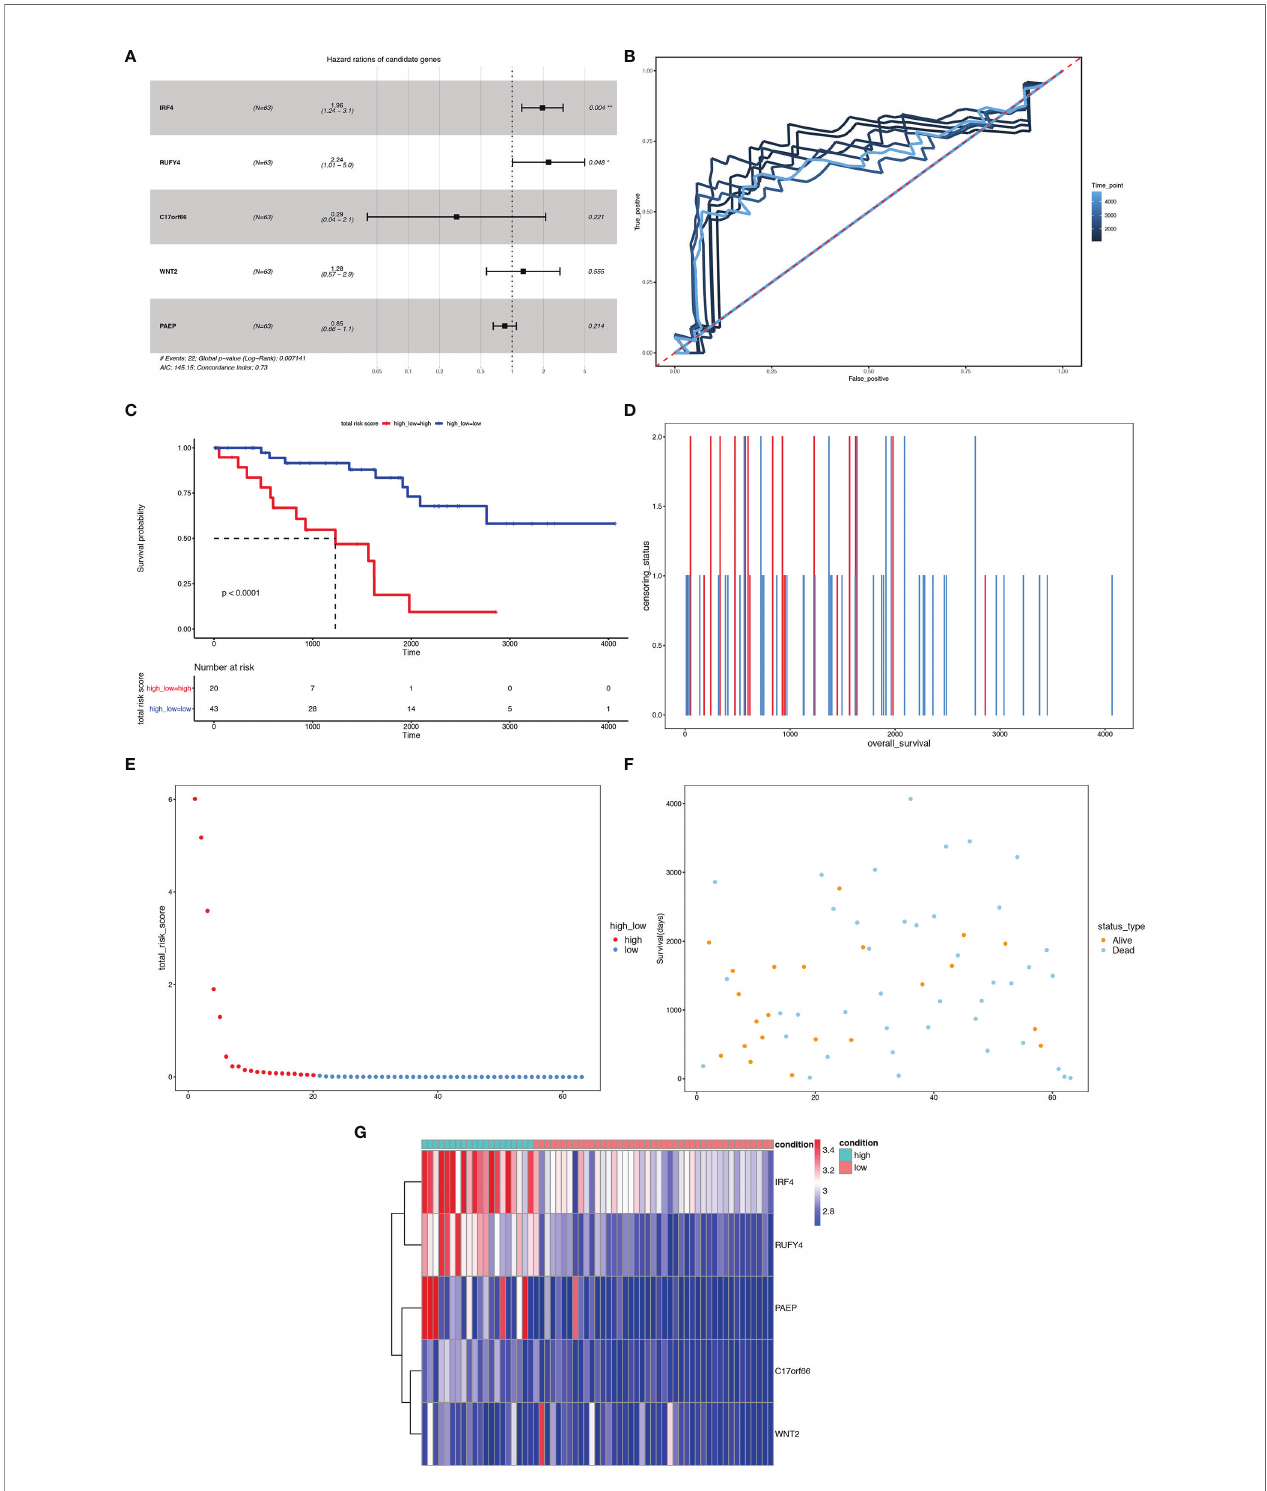
FIGURE 15 | Risk score analysis of the 5-gene signature-based prognostic model in the test group ccRCC patients. (A) Five-gene multivariate prognosis model for the test group ccRCC patients. (B) Time dependent ROC curve analysis exhibits the prognostic performance of the fi ve differentially expressed gene signature-based prognostic model in predicting 1 – 5-year survival times of the test group ccRCC patients in the TCGA-KIRC cohort. (C) Kaplan – Meier curve shows the overall survival of high- and low-risk ccRCC patients in the TCGA-KIRC cohort. (D – F) Survival bar, risk curve, and survival scatter plot analysis show surviving status of patients of high- and low-risk. (G) Heat maps of expression pro fi les of 5 genes obtained using multivariate Cox regression. *P < 0.05, **P <